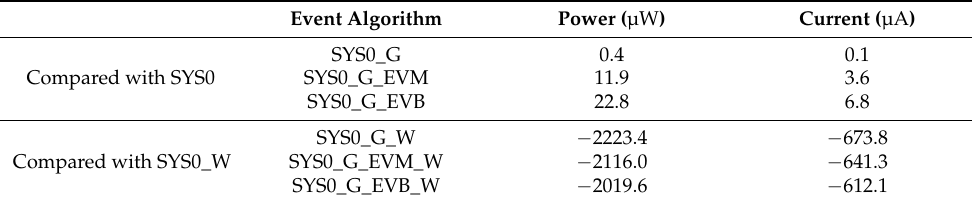
Table 9. Additional power and current requirements of running the event-based algorithm on